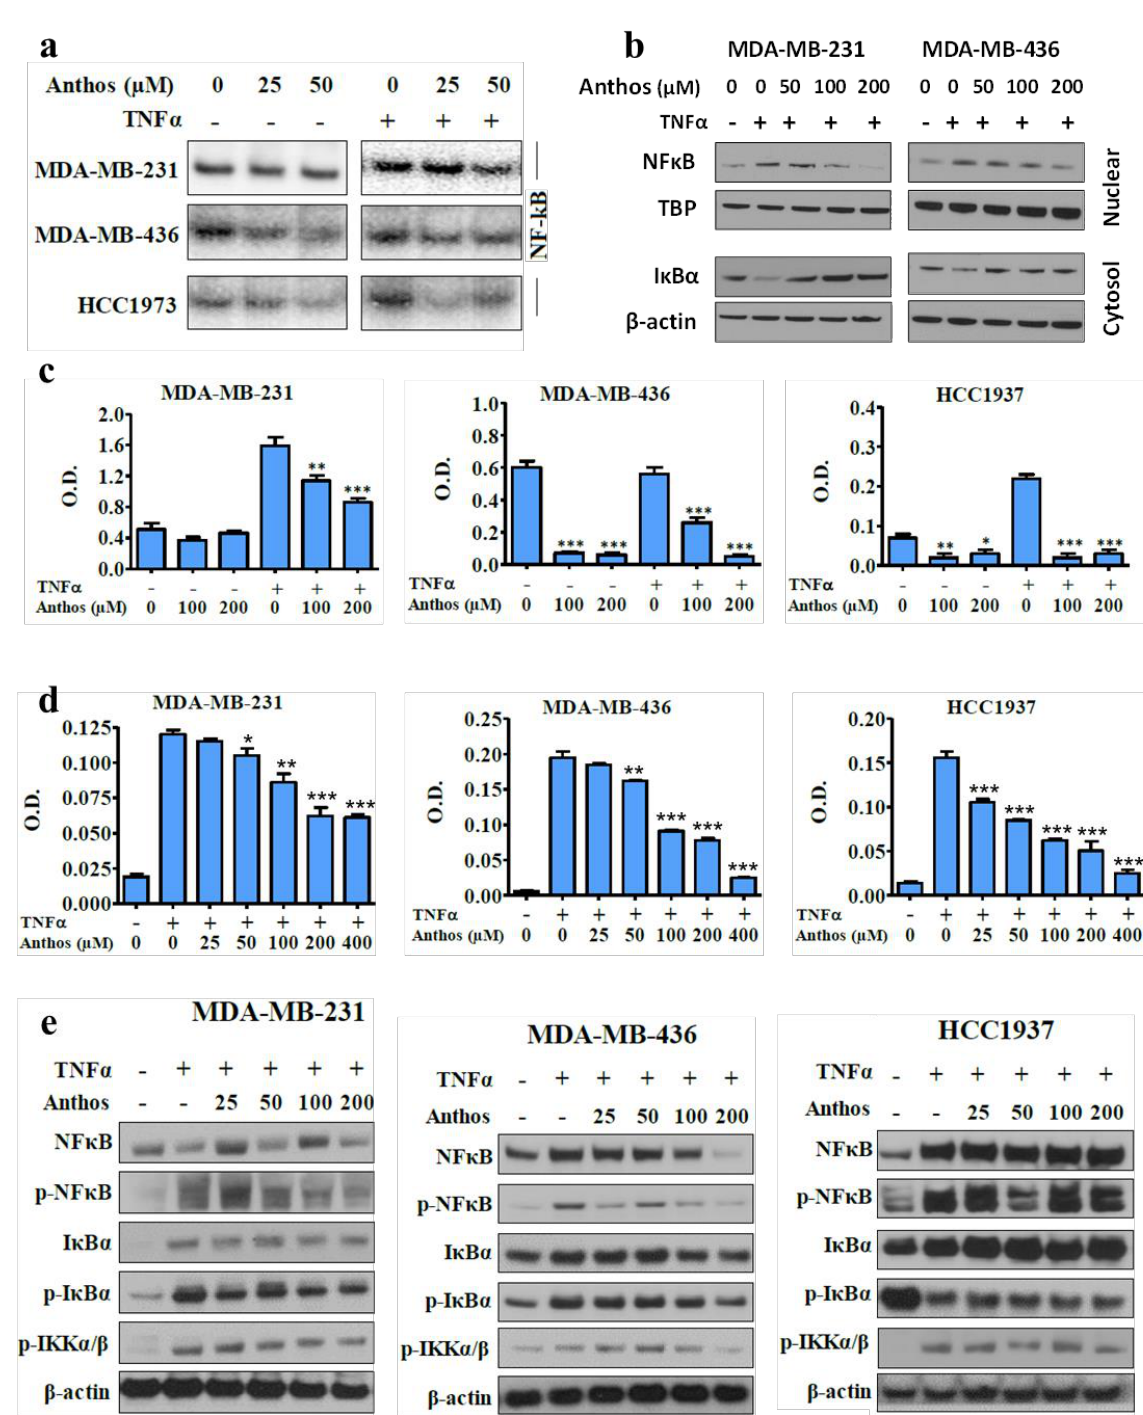
Figure 2. Effect of Anthos on NF- κ B activation, nuclear translocation, and related protein molecules in TNBC: ( a ) BC cells were treated with Anthos (0–50 µ M) in the presence or absence of TNF α for 48 h and nuclear extracts were analyzed by EMSA; ( b ) Cells were treated with Anthos (0–200 μM) for 48 h, and nuclear and cytosol lysates were probed for NF-κB and IκBα proteins by Western blot. Equal loading was confirmed by tata binding protein (TBP) and β-actin, respectively; ( c ) Effect of bilberry Anthos on NF- κ B activation. Breast cancer cells were treated with Anthos (100 and 200 µ M) in presence or absence of TNF α for 48 h, and nuclear extracts were analyzed by ELISA: ( d ) Whole-cell lysates were prepared and immune-precipitated with anti-IKK β antibody. The immuno-complex kinase assay was performed by ELISA using a CycLex ® IKK α and β Kinase Assay/Inhibitor Screening Kit; ( e ) Whole-cell lysates were probed for I κ B α and P65 levels. Equal loading confirmed by β -actin. Statistical analysis was carried out using student’s t -test; * p < 0.05; ** p < 0.01; *** p < 0.001. Densitometry data are presented in Figures